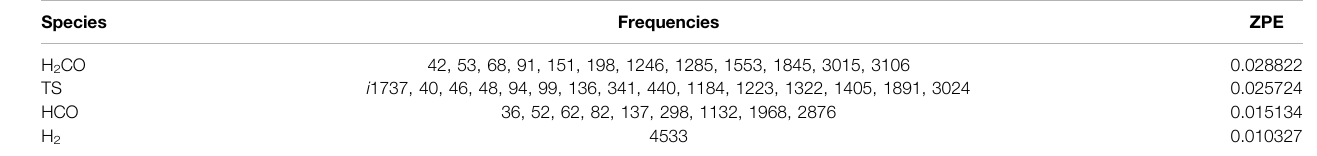
TABLE 3 | Calculated harmonic vibrational frequencies (in cm − 1 ) and zero-point energies (in Hartrees) for the stationary points. Species